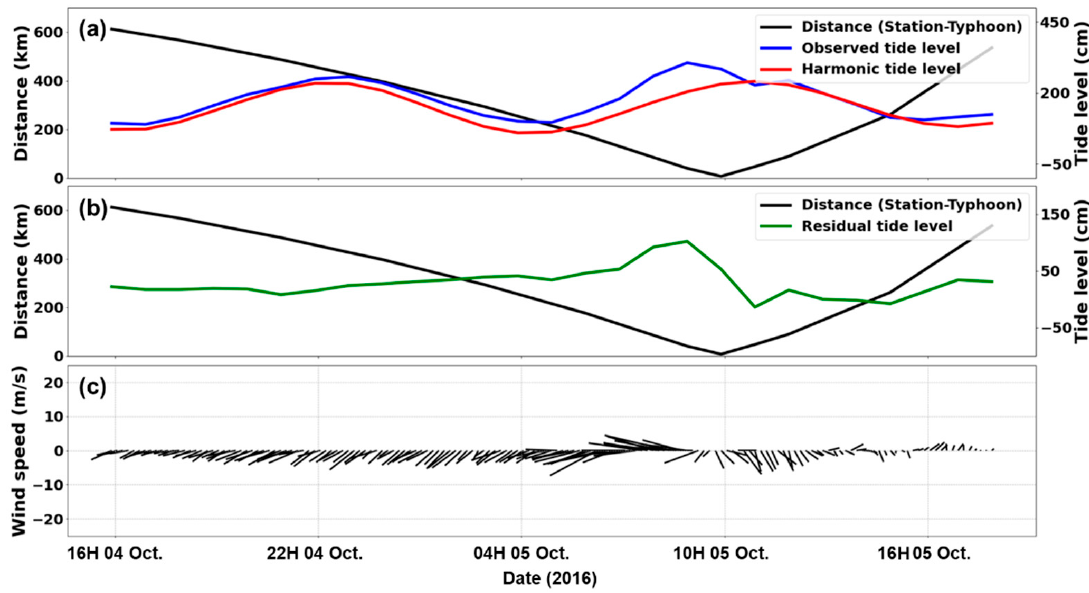
Figure 8. Time-series of observational data from Tongyeong tidal station during Typhoon Chaba. ( a ) Astronomical tide, ( b ) residual tide level, and ( c ) wind components, where direction and length represent wind direction and speed, respectively.